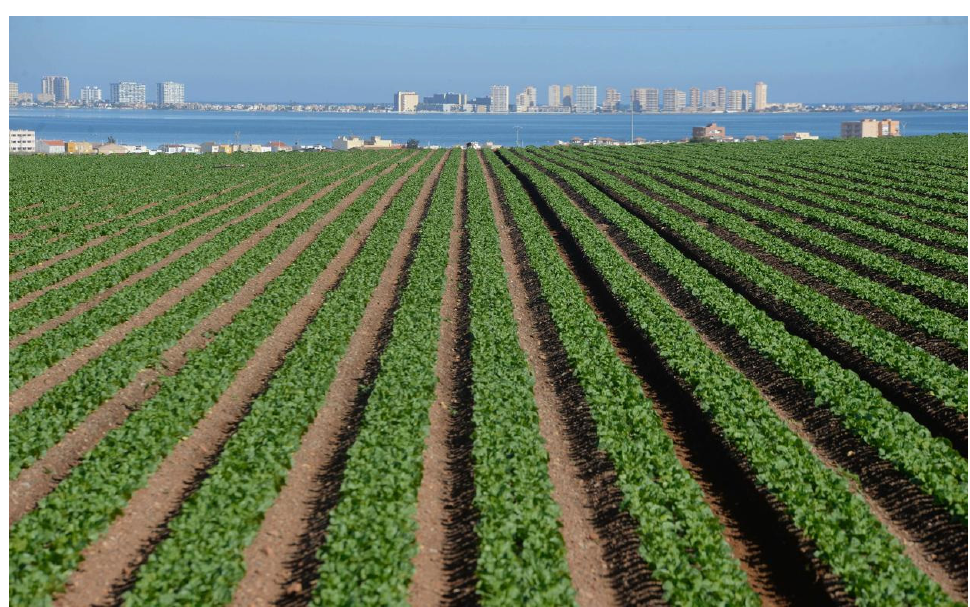
Figure 6. Increase in irrigated areas in the Campo de Cartagena (Spain). Source: Murcia Diario [72]. Note: The Campo de Cartagena (south-east Spain) is one of the Spanish regions in which the demand for water has increased the most in recent decades due to the creation of irrigated crops and urban- tourism